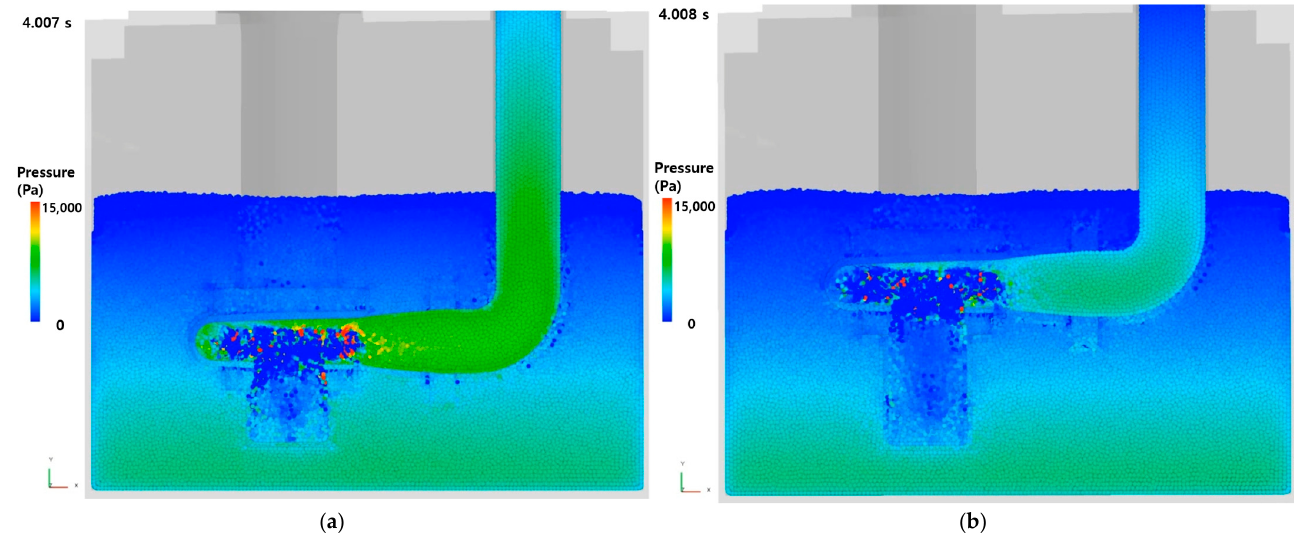
Figure 8. Pressure image according to pump driving force: ( a ) Original model; ( b ) change strainer length.